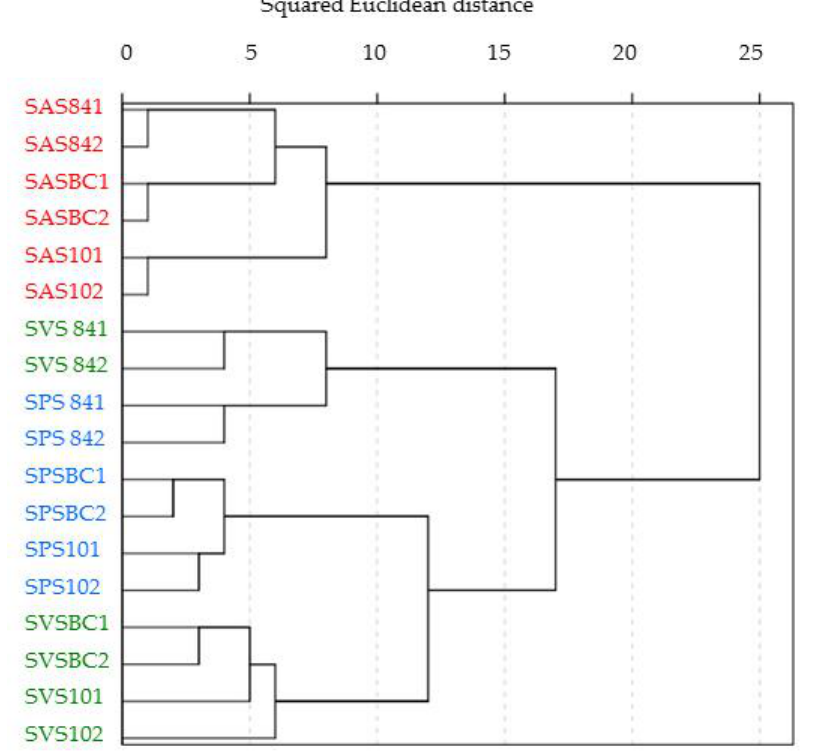
Figure 4. Dendrogram of the hierarchical cluster analysis based on Euclidean distances (average linkage method) of bacterial communities in biopurification systems composed of SAS, SVS and SPS biomixtures, before the contamination (BC) and at 10 and 84 days after the addition of the PPCPs. Table 4. Percentages of the relative abundance of bacterial phyla and bacterial classes in the biopurification systems as- sayed before contamination (BC) and at 10 and 84 days after the addition of the PPCPs. SAS SVS SPS